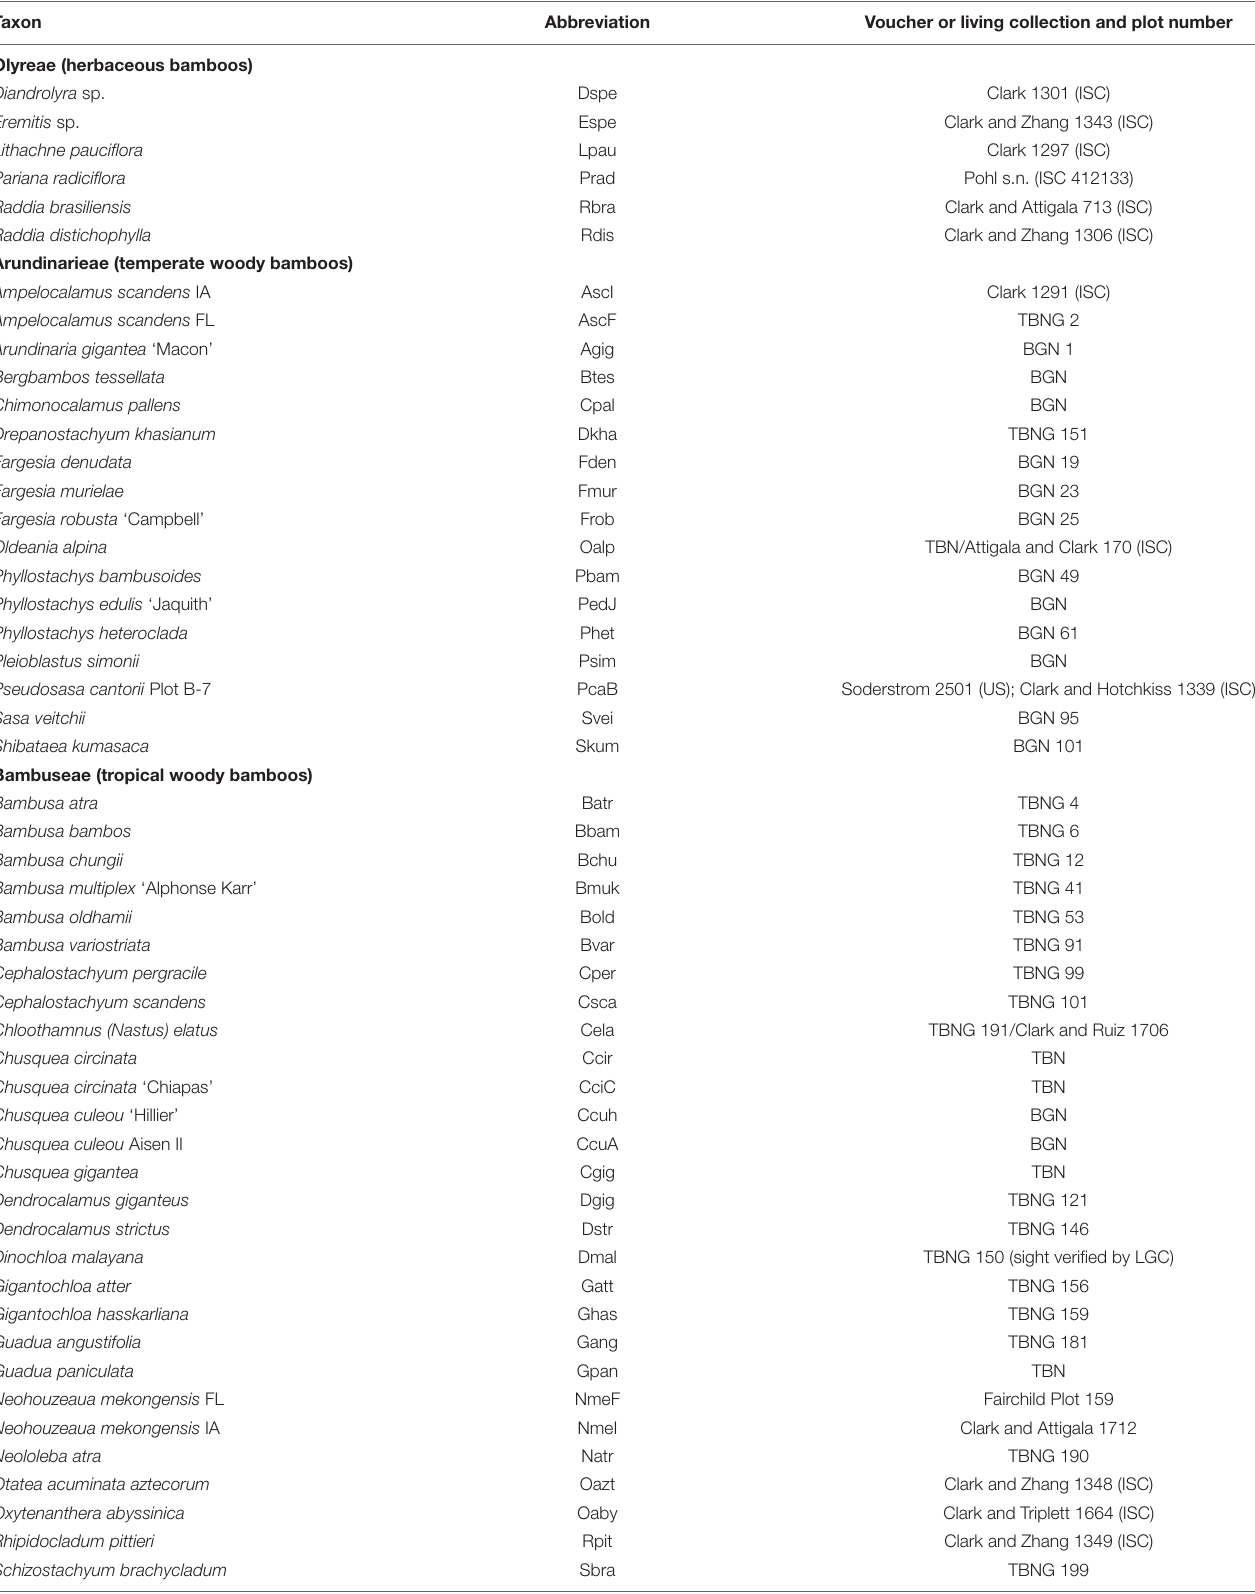
TABLE 1 | Taxa sampled for the 51 plastome and repeat